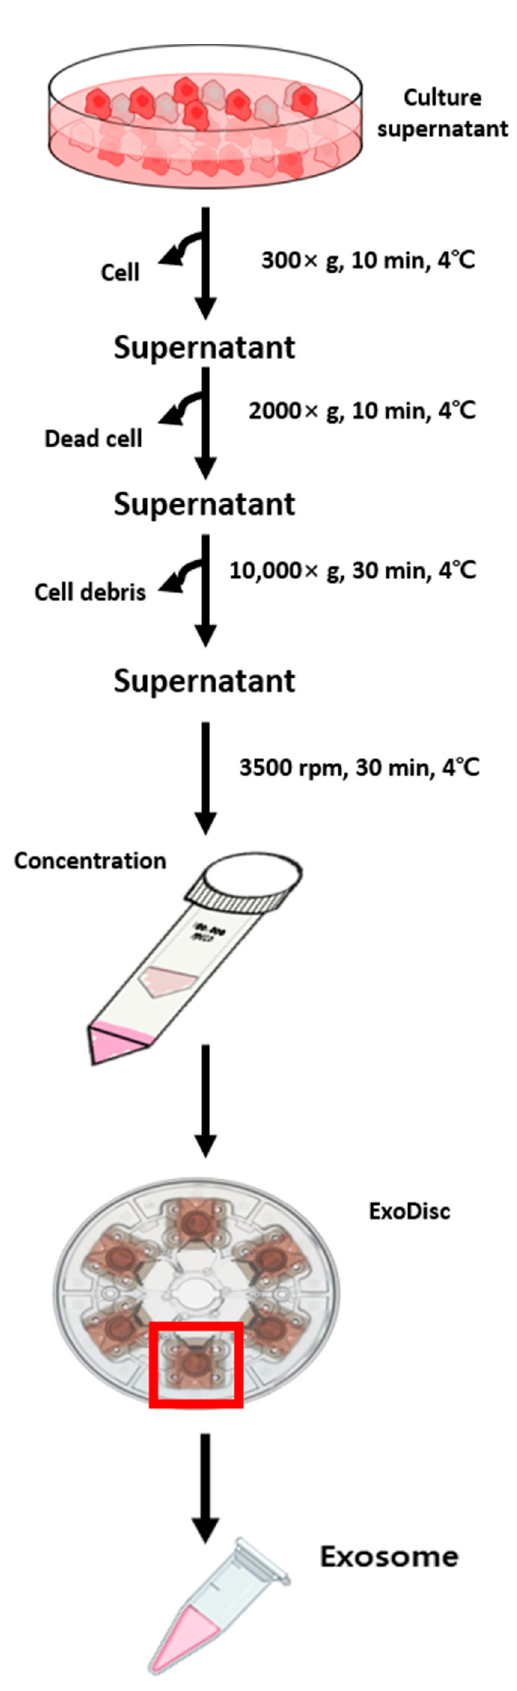
Figure 1. Exosome isolation from the cell culture supernatant using ExoDisc.